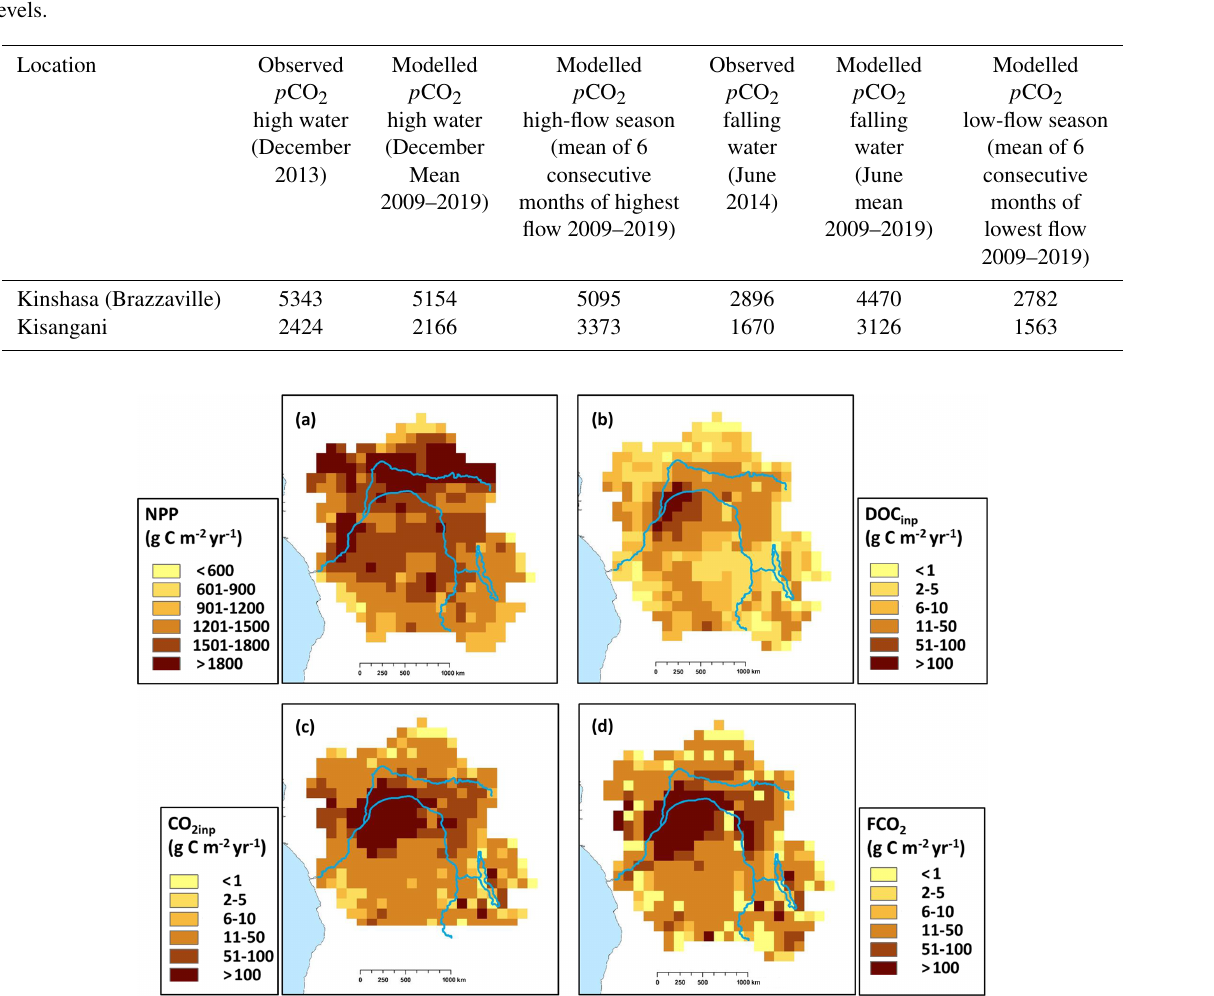
Figure 8. Present-day (1981–2010) spatial distribution of (a) terrestrial net primary productivity (NPP), (b) dissolved organic carbon export from soils and floodplain vegetation into the aquatic system (DOC inp ), (c) CO 2 leaching from soils and floodplain vegetation into the aquatic system (CO 2inp ), and (d) aquatic CO 2 evasion (FCO 2 ). Main rivers are in blue. All are at a resolution of 1 ◦